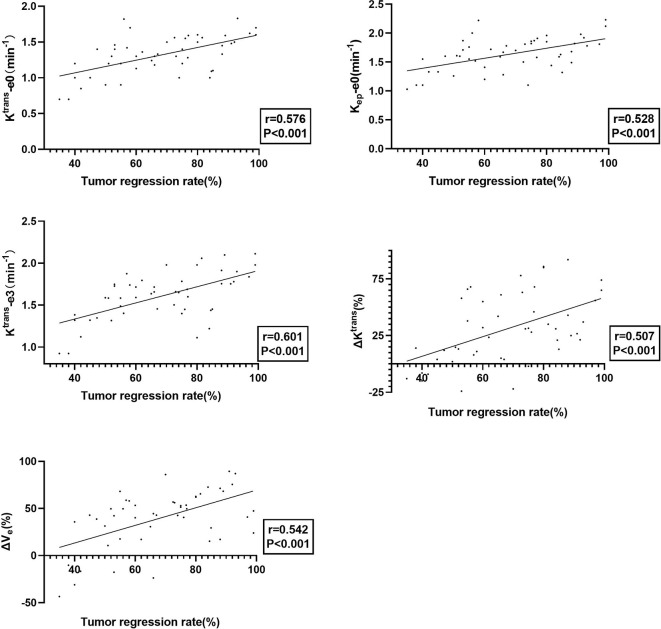
The plot of Ktrans-e0, Kep -e0, Ktrans-e3, ΔKtrans, and ΔVe with tumor regression rate, showing that tumors with better treatment response exhibited better permeability and perfusion.